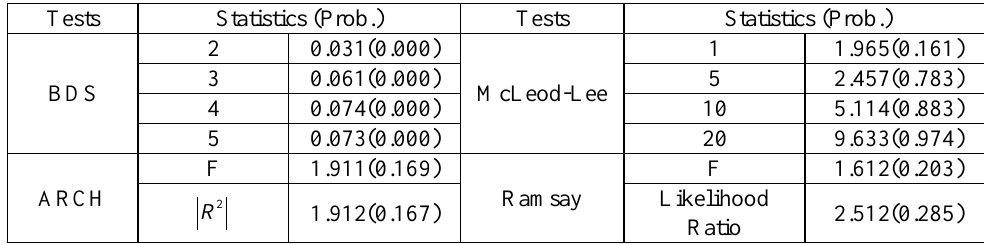
Table 2. Nonlinearity Test of the